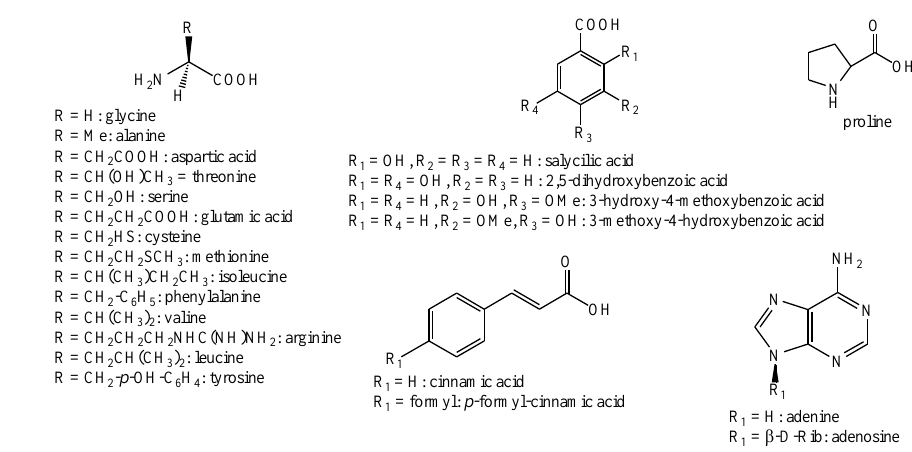
Figure 20. Other compounds identified in Pedicularis species—part 1.